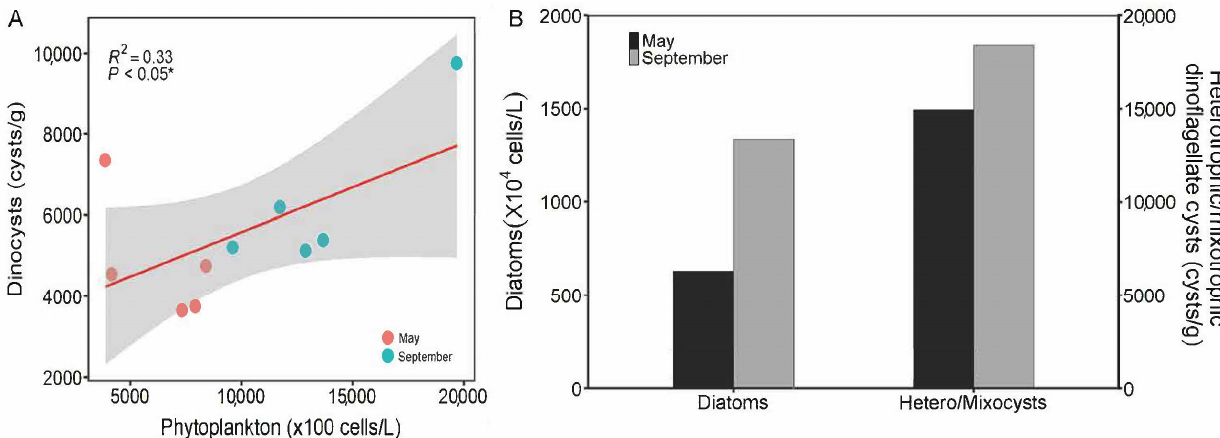
Figure 10. Relationship between phytoplankton abundance and dinoflagellate cyst abundance. ( A ) Linear regression of phytoplankton abundance and dinoflagellate cyst abundance in the study region in May and September. Red indicates abundance in May, and blue indicates abundance in September. The abundance of phytoplankton and cysts in September was significantly higher than that in May (Wilcoxon rank-sum test; p < 0.05). As phytoplankton abundance increased from September to May, dinoflagellate cyst abundance also increased proportionally. ( B ) Comparison of diatom and heterotrophic/mixotrophic cyst abundance in May and September. A Wilcoxon rank-sum test was performed to compare the difference in abundance between May and September ( p < 0.001 for diatoms, p < 0.5 for heterotrophic/mixotrophic dinoflagellate cysts). Hetorocyst = heterotrophic/mixotrophic dinoflagellate cysts.